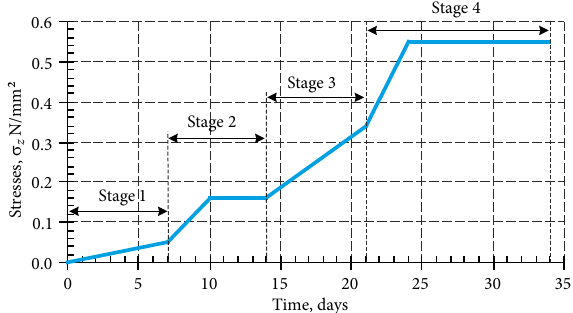
Fig. 2. The scheme of specimen that are loaded with a changing in time load